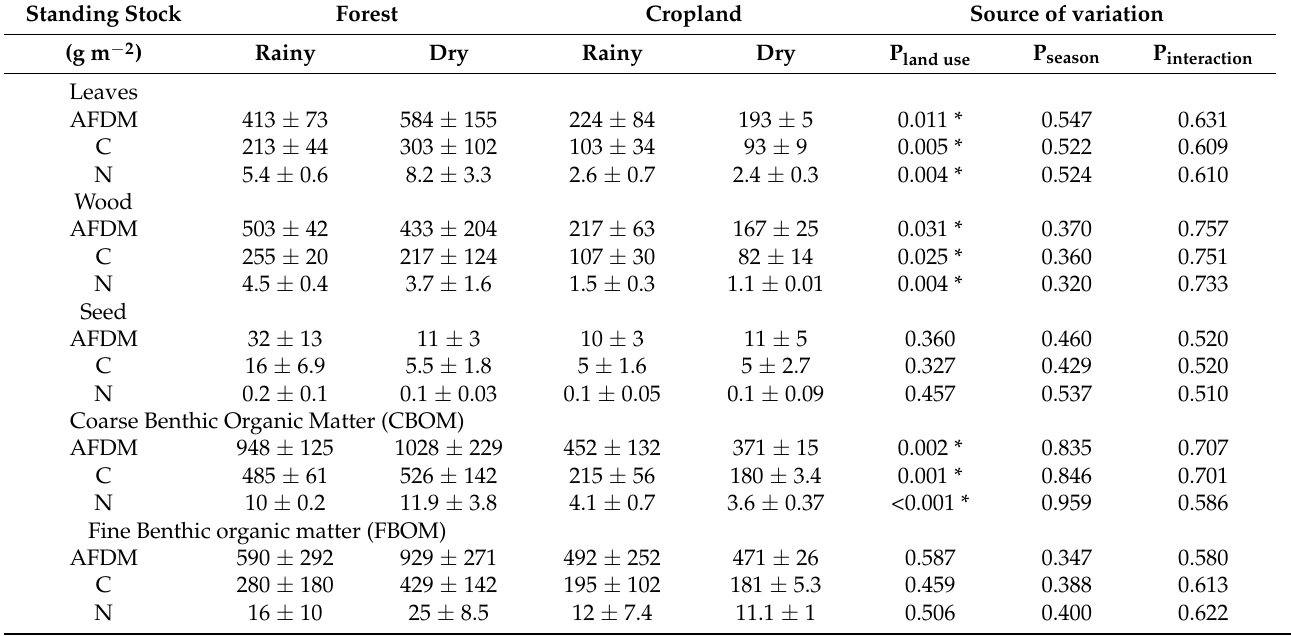
Table 2. The mass of organic matter (as ash-free dry mass; AFDM), carbon (C) and nitrogen (N) in benthic organic matter standing stocks (mean ± SE) in forest and cropland streams in the rainy and dry seasons, and results of statistical analyses. Total coarse benthic organic matter is the sum of leaves, wood and seeds. Bold text and * indicate statistically significant effects ( p <